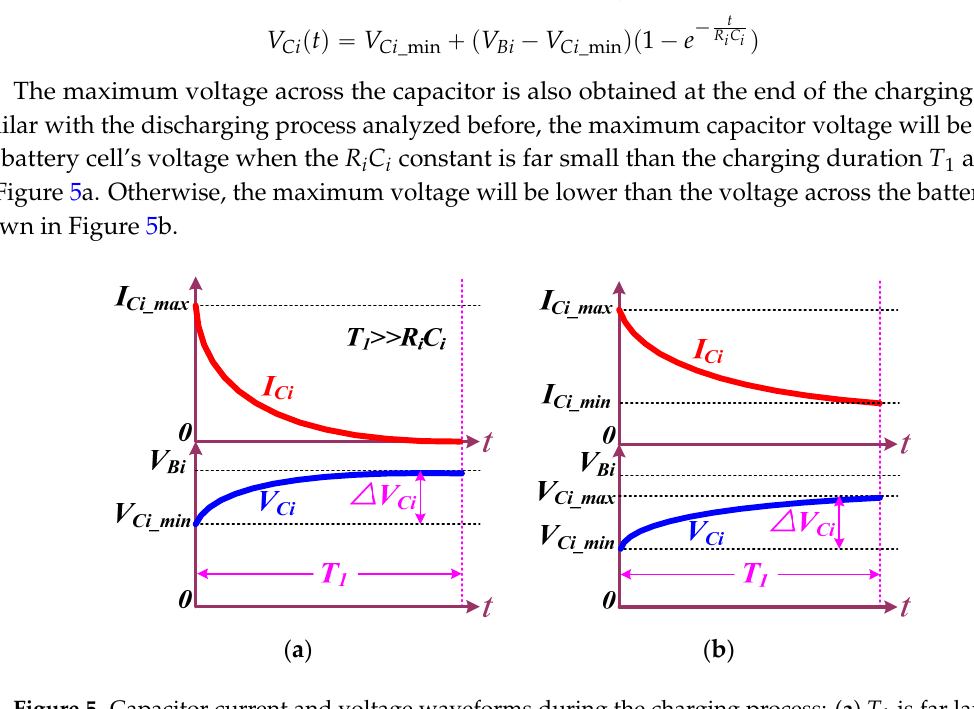
Figure 5. Capacitor current and voltage waveforms during the charging process: ( a ) T 1 is far larger than R k C k ; ( b ) T 1 is not far larger than R k C k .